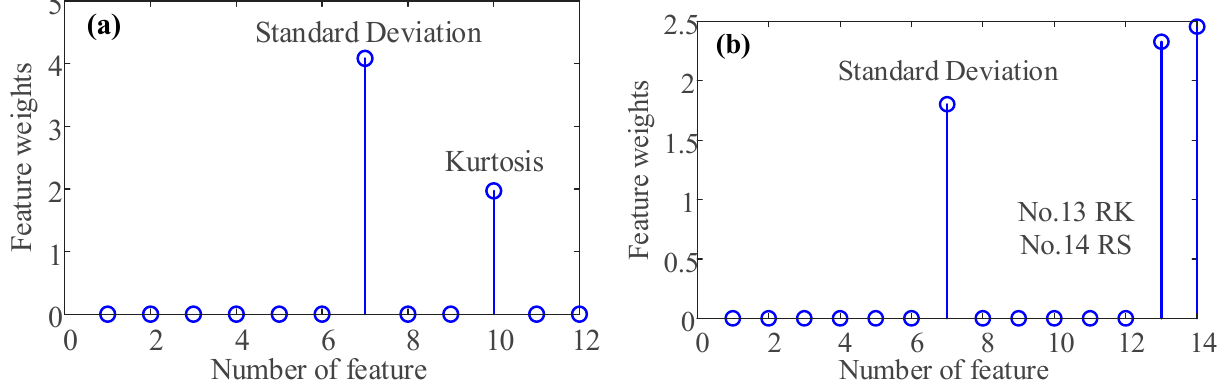
Figure 14. Feature weights of the sensitive feature from ( a ) feature parameter set 1 ( b ) feature parameter set 2.